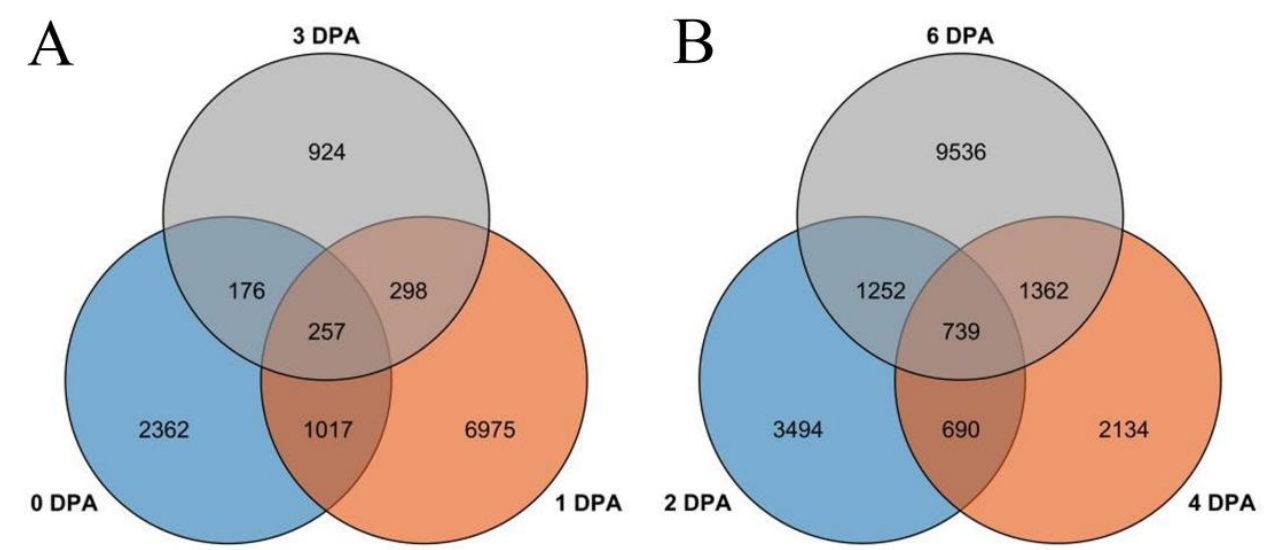
Figure 4. Venn diagram of genes of four materials in different periods: ( A ) Xinluzao 50 and Xinluzao 50FLM; ( B ) CSS386 and Sicala V-2.